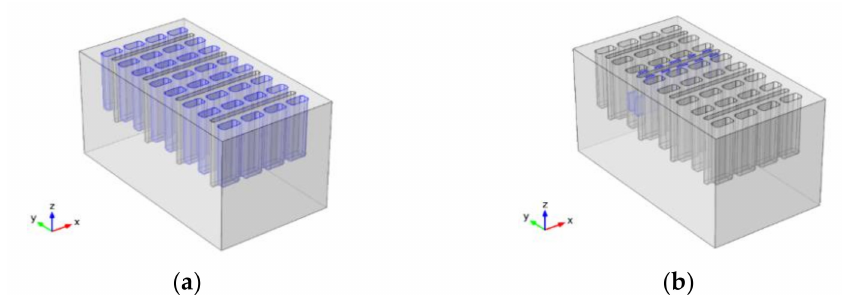
Figure 5. Electrolysis tank model: ( a ) without brush plate; ( b ) with brush plate.